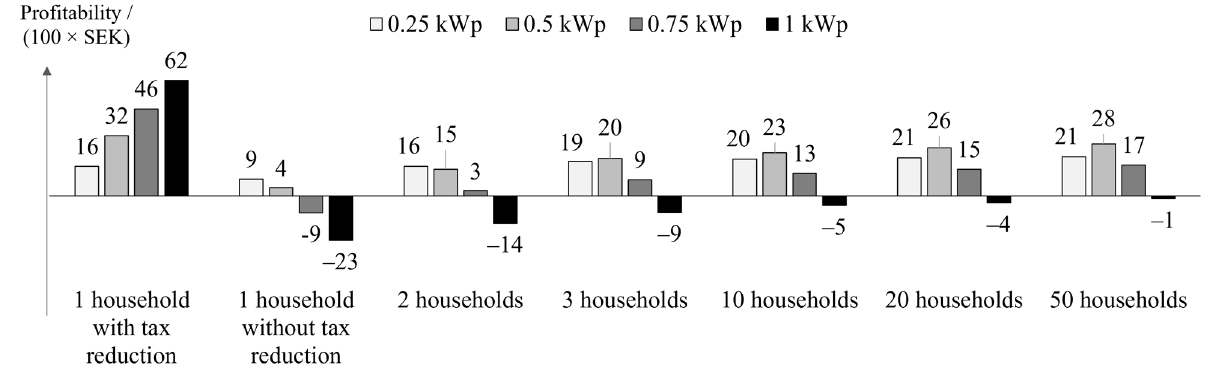
Figure 12. Comparison of the profitability of a single household receiving tax reduction to the shared PV communities without tax reduction in Karlstad with an electricity price growth of 2%.